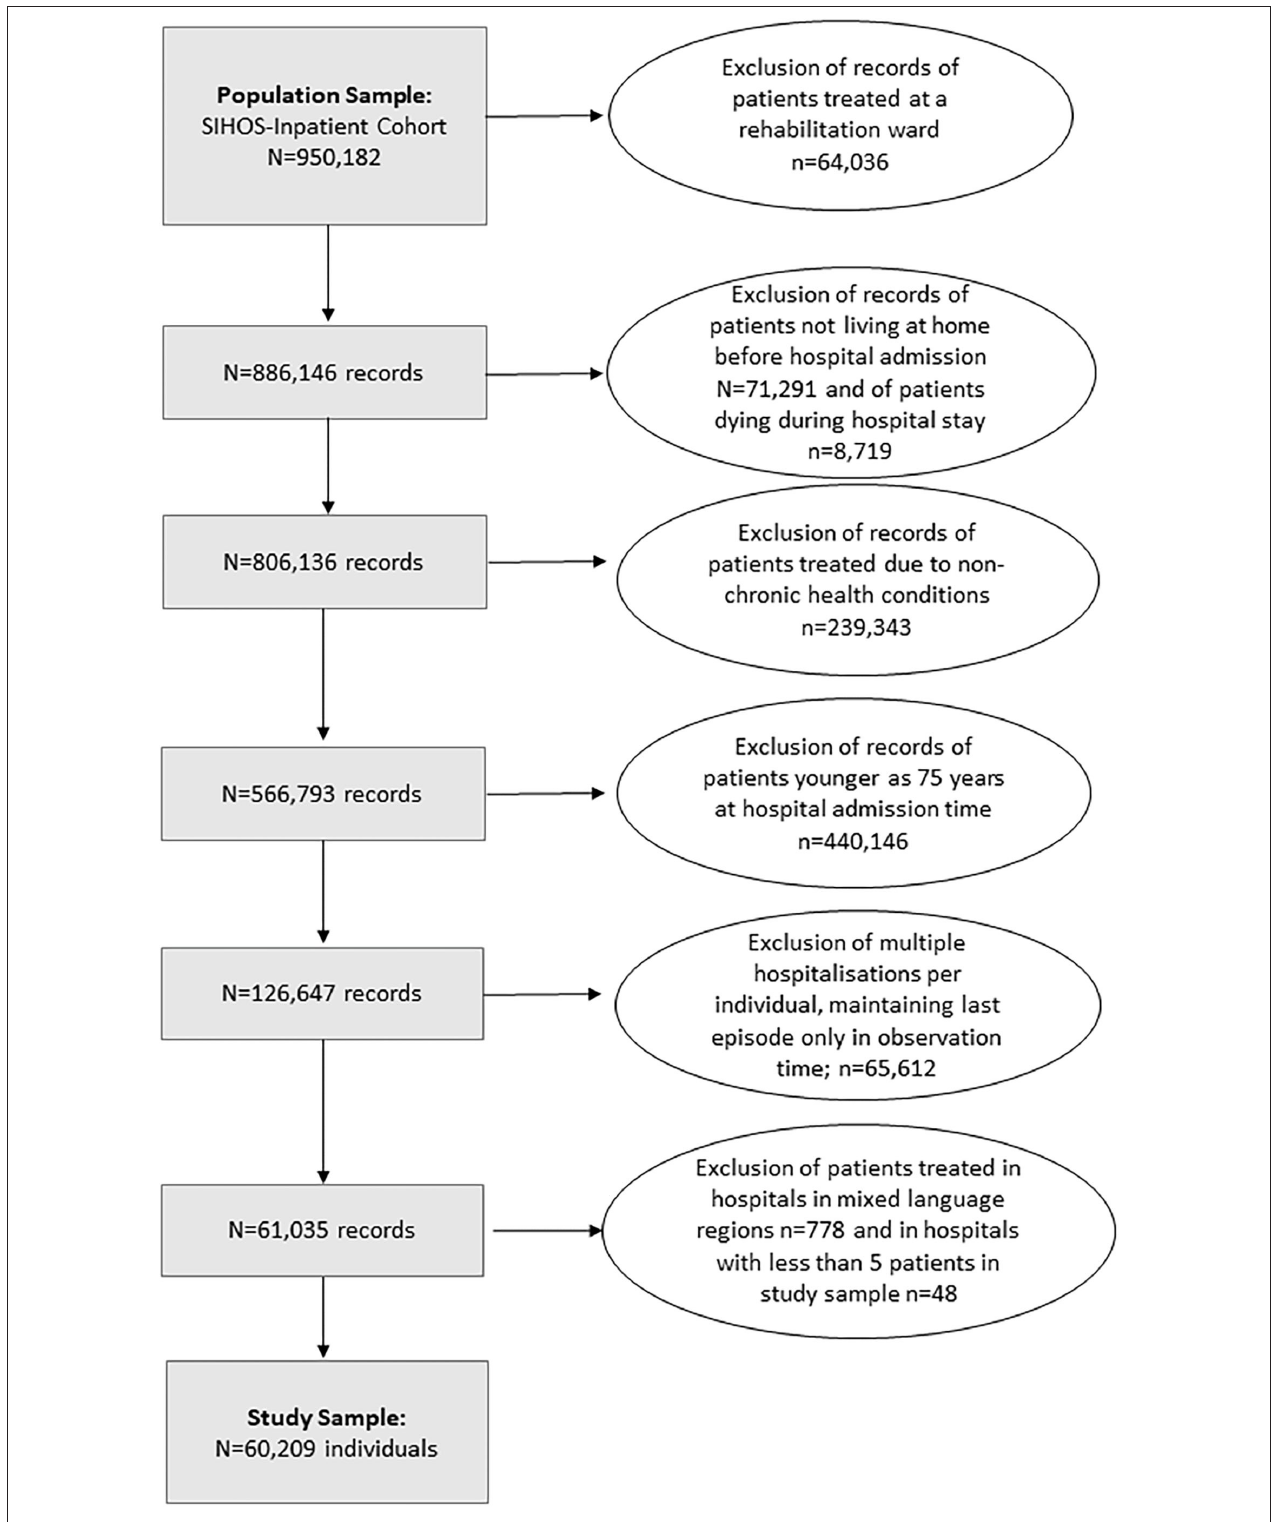
FIGURE 2 | Flow chart of selection of cases to define the study sample ( N = 60,209 individuals).